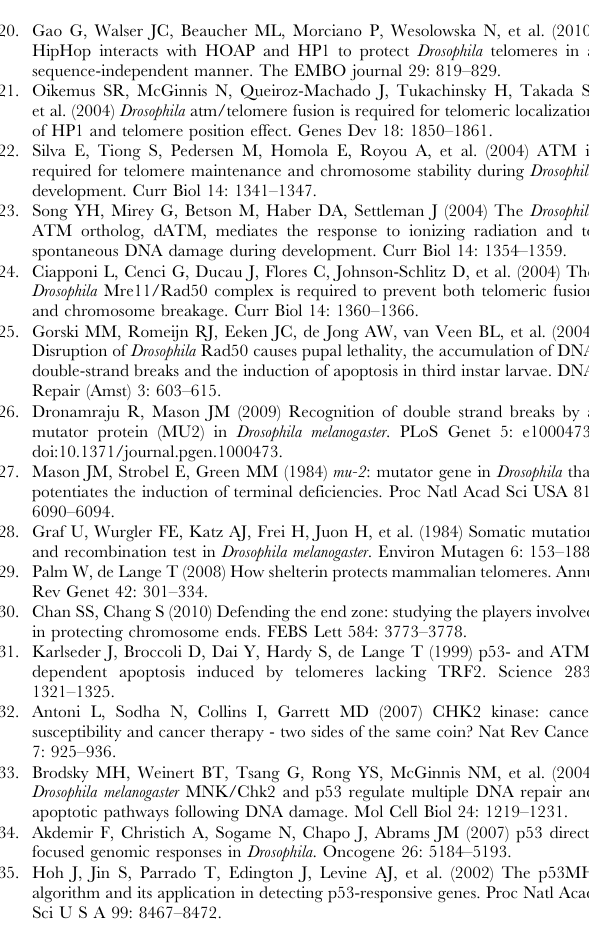
Figure S1 Bar Stone induced apoptosis. Eye and antennal discs dissected from males carrying a wildtype Y (left) or DcY(H1) (right) were stained with an antibody against cleaved caspase-3. (EPS) Figure S2 Cell survival after telomere loss at different time points in development. Clone size and clone number were scored. The data presented here are the basis for the total mwh cells per wing presented in Figure 7. Table S1 Table of statistical results for SMARTL assay. Students t-test was